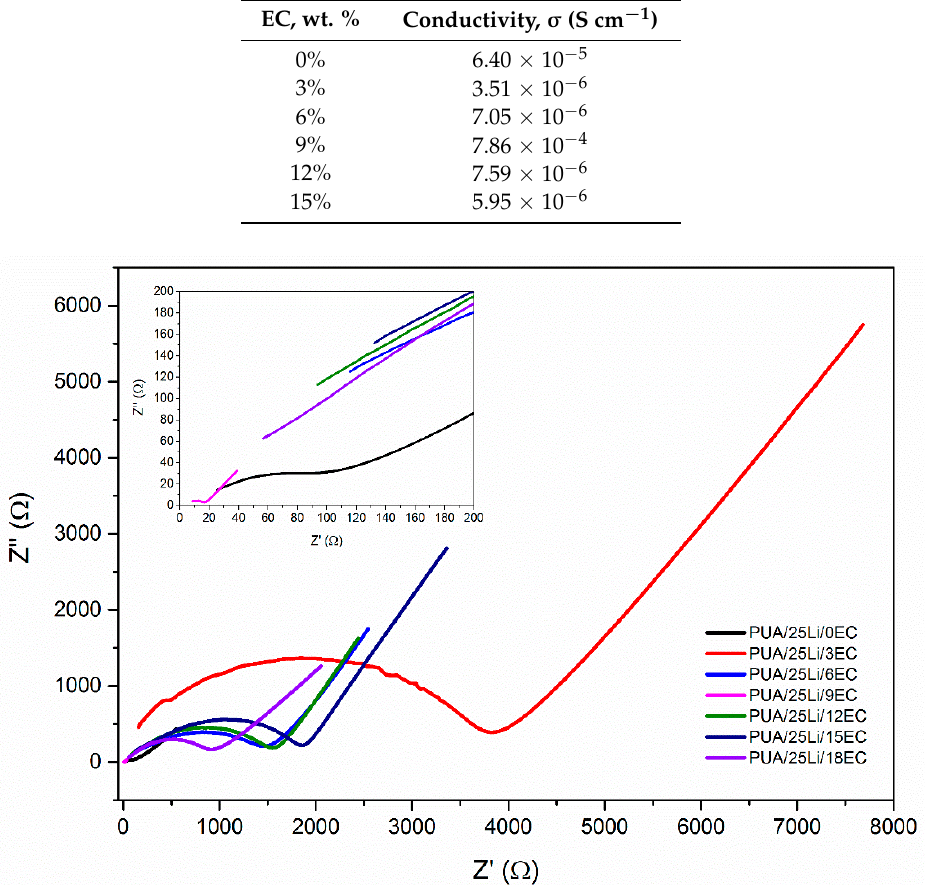
Table 1. Ionic conductivity of PUA electrolyte with EC plasticizer.